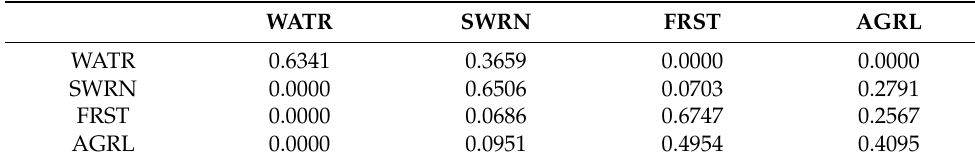
Table 2. Transition probabilities matrix for the year 2028.